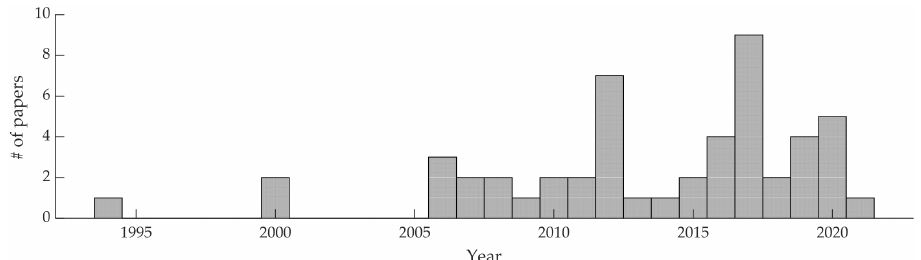
Figure 1. Number of papers included in this review as a function of the publication year.